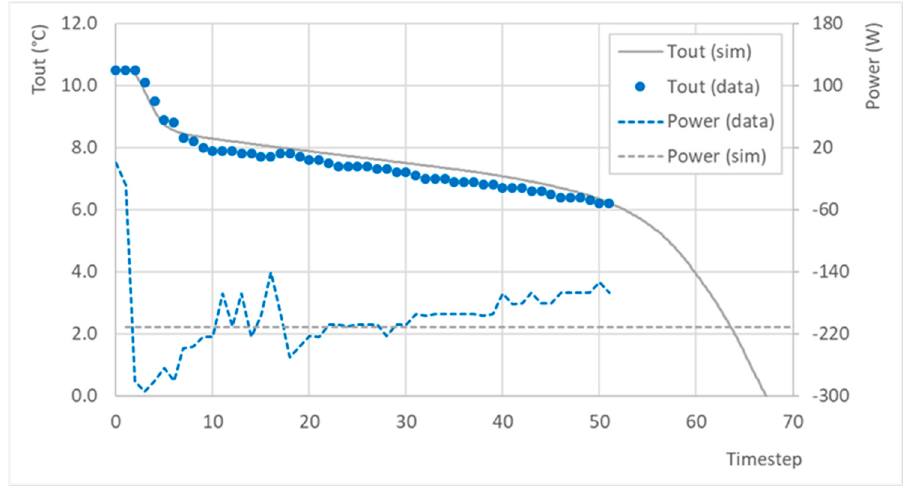
Figure 3. RT-6 PCM transition region: simulated vs. experimental data. Table 1. PCM thermal properties.